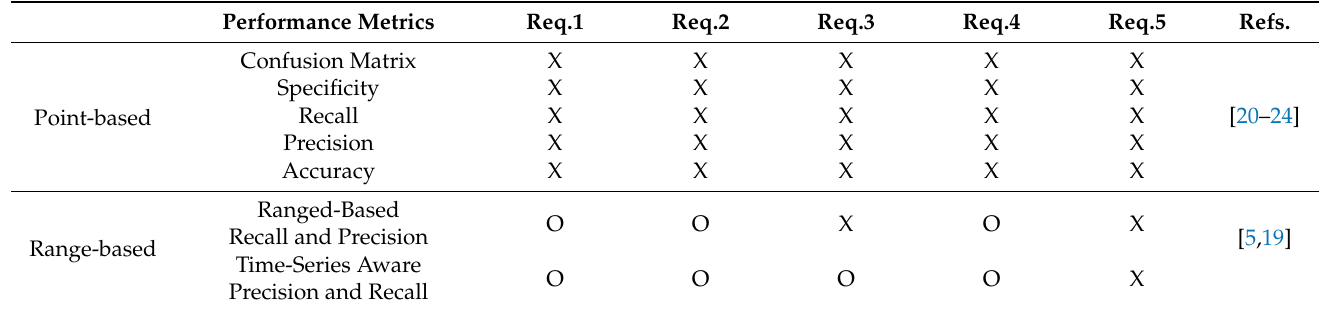
Table 4. List of papers researching anomaly detection targeting ICS operation data. (O: Satisfy a requirement, X: Not satisfy a